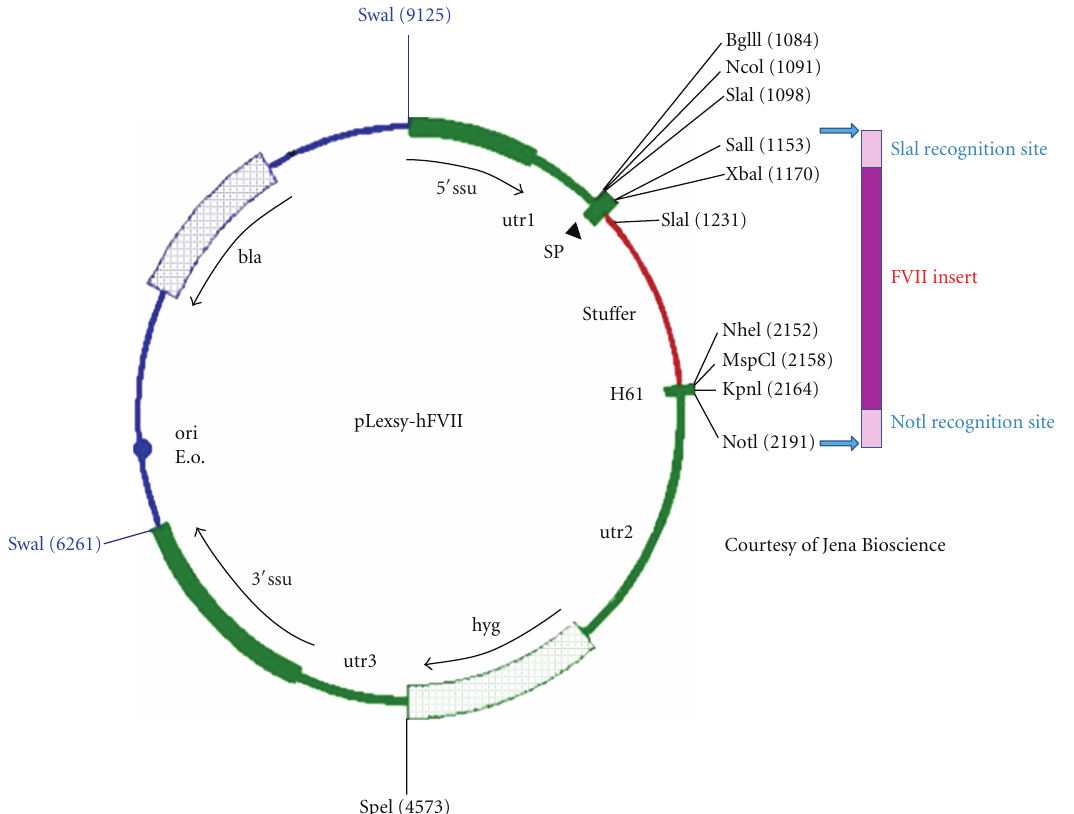
Figure 3: Construction of expression plasmid containing human FVII (pLexsy-hFVII). Map of pLEXSY-2 vector and the strategy used for plasmid construction are shown. The cDNA sequence encoding human FVII was inserted in corresponding restriction sites SlaI and NotI. More information about the vector itself can be found on http://www.jenabioscience.com/, pLEXSY-hyg2